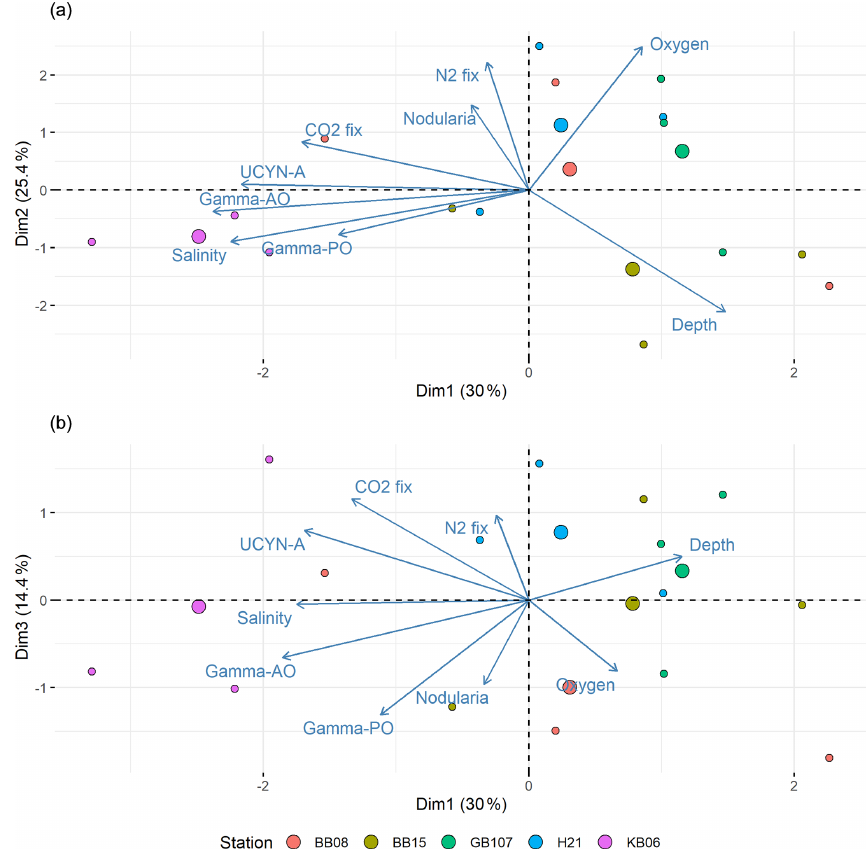
Figure 8. Principal component analysis (PCA) of components 1 and 2 (a) and components 1 and 3 (b) . Positive correlations were identified between salinity and UCYN-A, while Nodularia and salinity are negatively correlated. Moreover, N 2 fixation correlated positively with Nodularia . Stations are color-coded. Each circle denotes one sampling point; bigger circles indicate the center for each